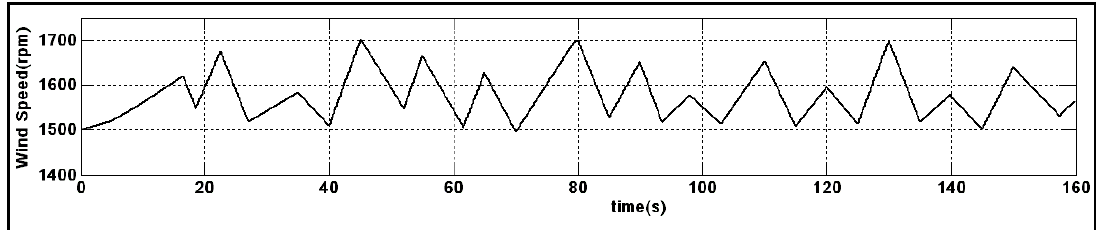
Figure 5. Wind speed profile.